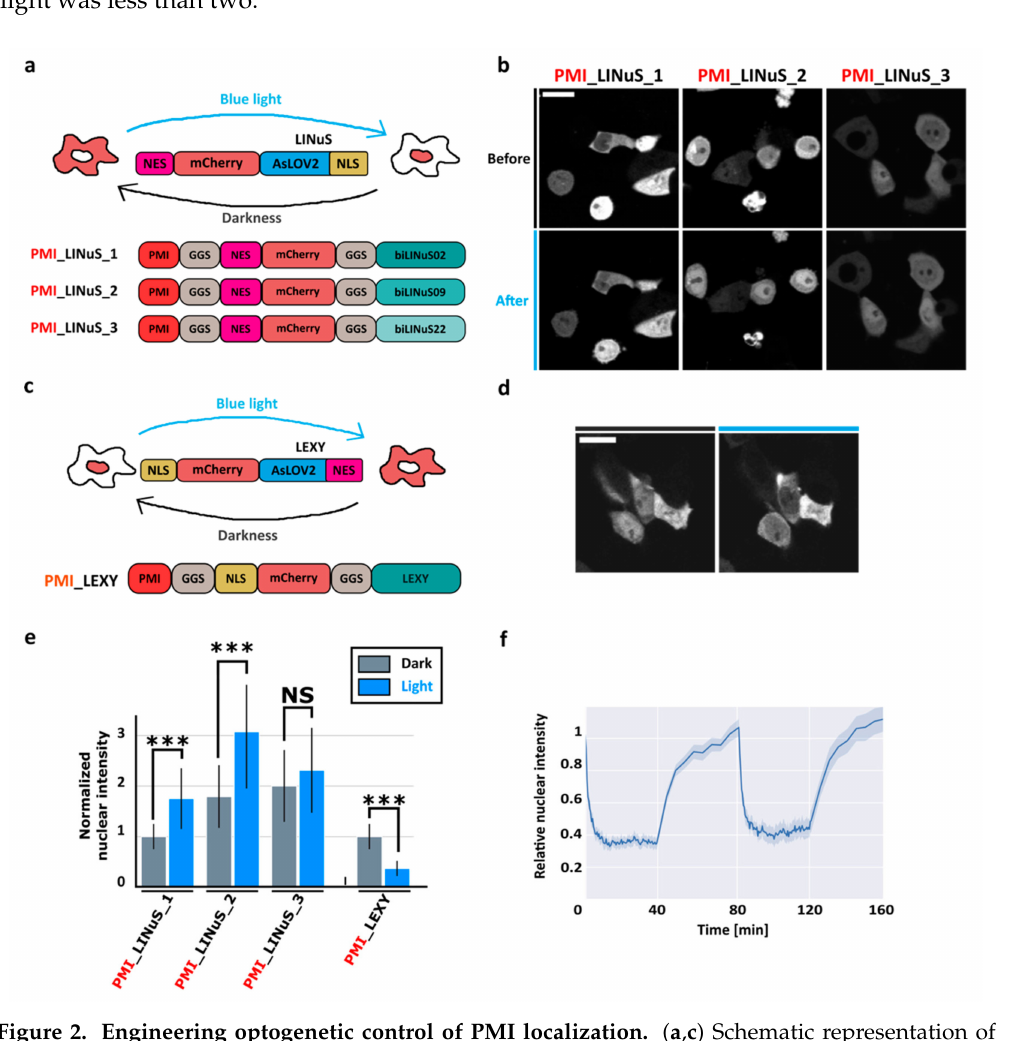
Figure 2. Engineering optogenetic control of PMI localization. ( a , c ) Schematic representation of the PMI_LINuS and PMI_LEXY constructs. The NES is the PKIt NES. GGS is a flexible linker. ( b , d ) Representative images of HCT116 cells transiently transfected with the indicated constructs before and after 40 min of blue light illumination. ( b , d ) Scale bar, 20 µ m. ( e ) Bar plot showing the nuclear intensity of the indicated constructs in the dark or after illumination with blue light normalized